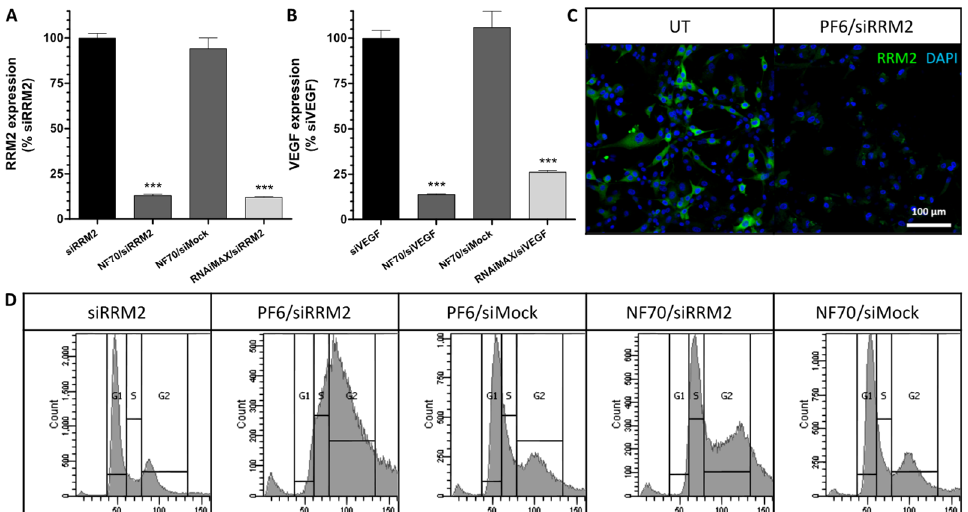
Figure 1. CPP/siRNA NPs induced therapeutic gene knockdown, RRM2 protein decrease, and cell cycle arrest in U-87MG cells. ( A ) RRM2 and ( B ) VEGF gene expression levels in tumor cells measured with qRT-PCR. Data were analyzed by 2 − ∆∆ CT method using GAPDH as an internal control and normalized to relevant pure siRNA groups. Error bars represent SEM, *** p < 0.001, one-way ANOVA, Tukey post hoc. ( C ) Representative immunocytochemical staining of RRM2 (green) in tumor cells counterstained with DAPI (blue); scale bar: 100 µ m. ( D ) Representative flow cytometry graphs of propidium-iodide-stained tumor cells. All of the data ( A – D ) were collected 48 h after transfection from 3 independent experiments. UT, untreated.